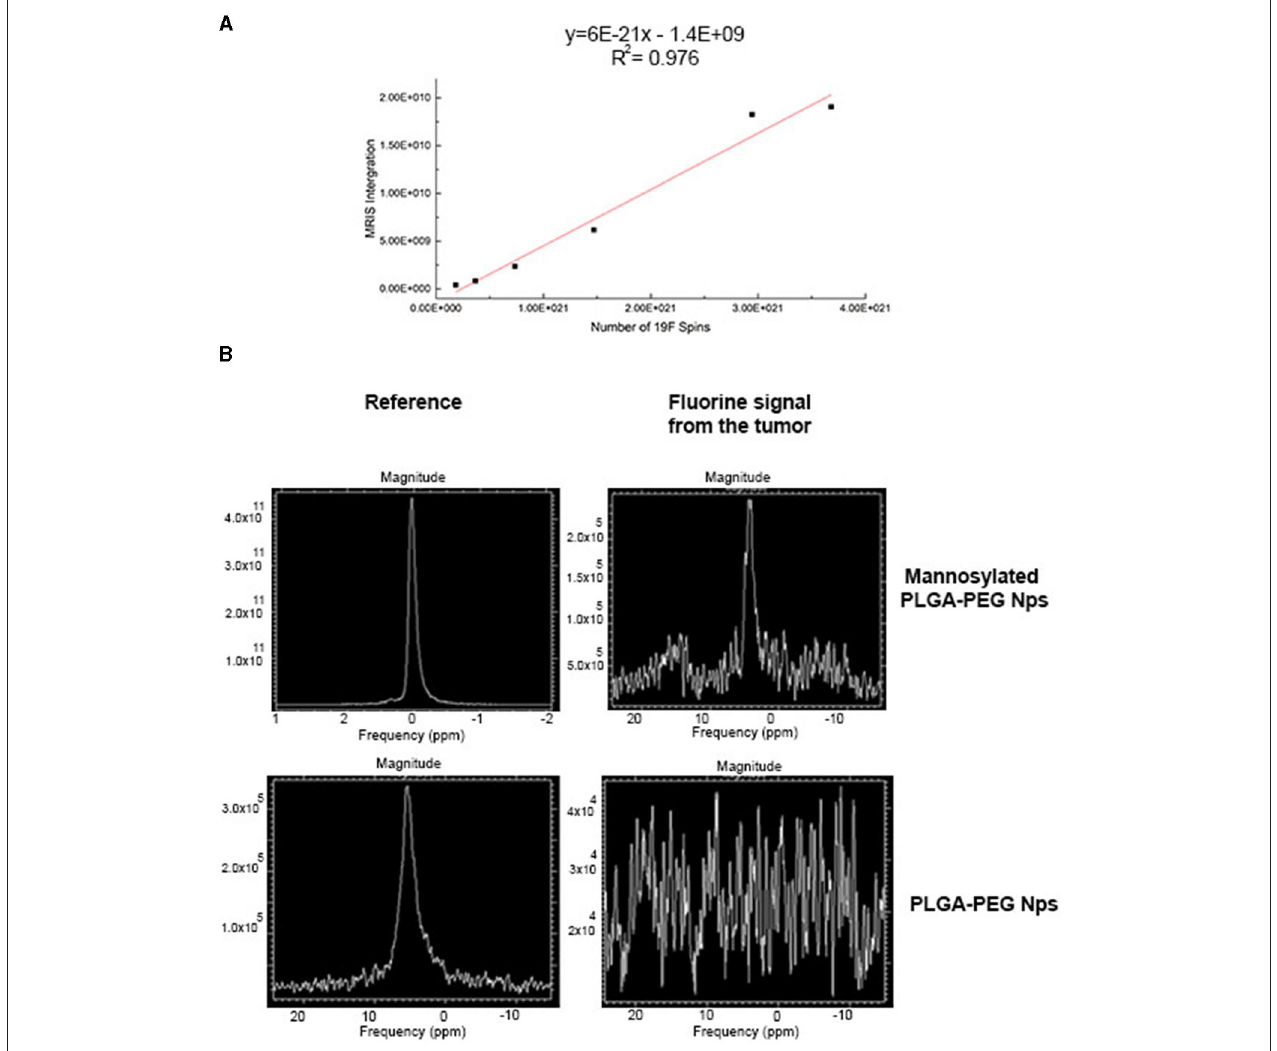
FIGURE 3 | PFCE magnetic resonance measurement by 19 F-MRI spectroscopy (MRS). (A) Standard curve of pure PFCE contrast agents measured at different dilution volumes ranging from 5 and 100 µ l. (B) 19 F-MRI spectrum of PFCE detected from 4T1tumor-bearing mice and treated with PLGA-PEG-mannose nanoparticles (top graph) and with PLGA-PEG nanoparticles (bottom graph). Respective external reference tubes (left) were used to set up image acquisition methods and for PFCE measurements at the tumor